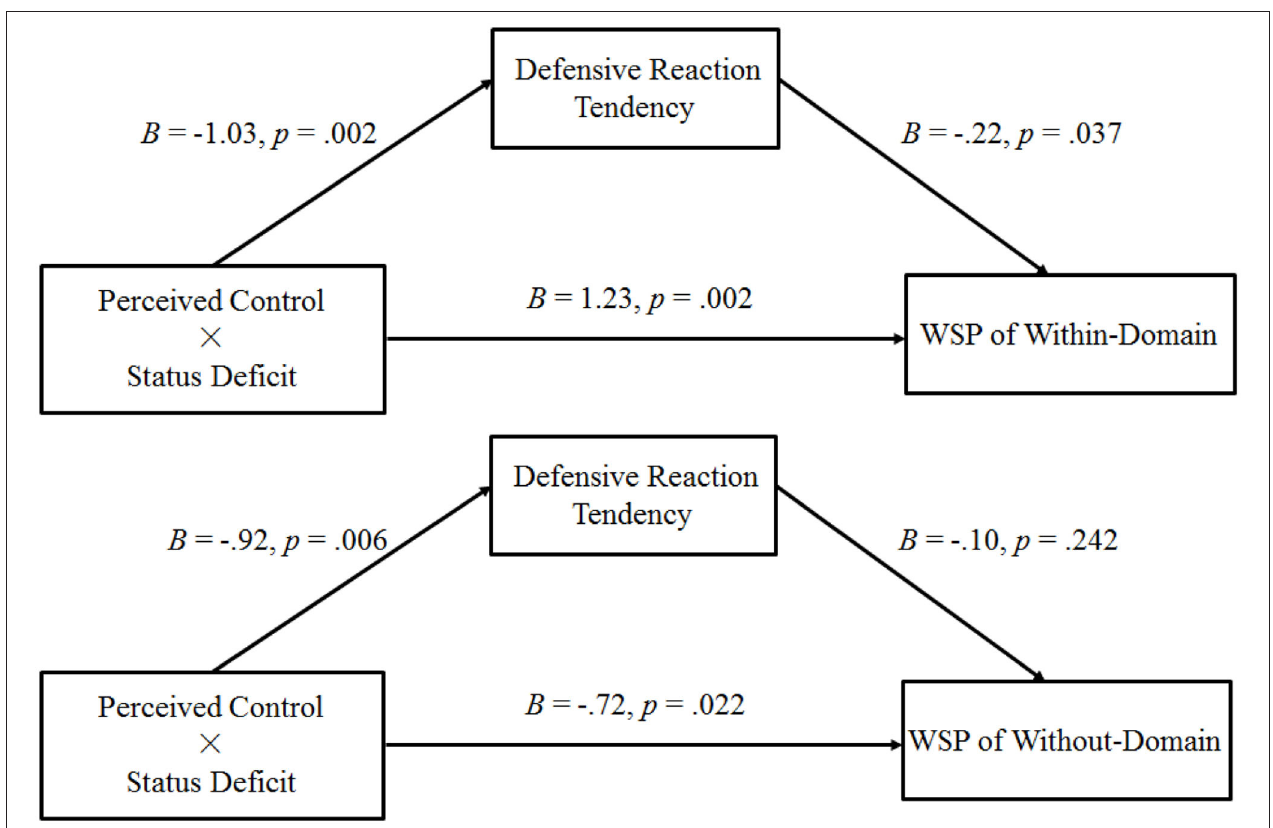
FIGURE 6 | Results of Experiment 3: path analysis of Experiment 3 (WSP, willingness to purchase self-improvement